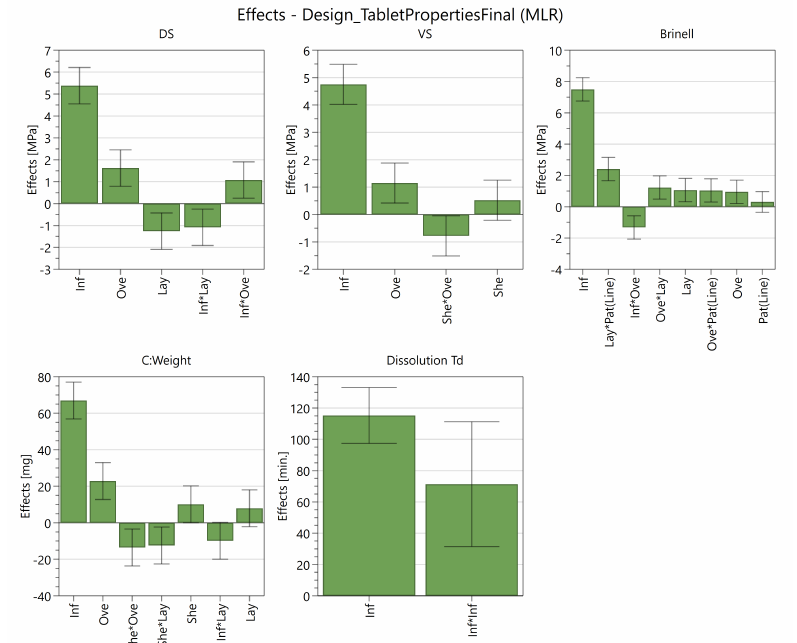
Figure 7. Optimized effect plots of the Brinell hardness, diametral (DS) and vertical strength (VS), weight and dissolution properties (T d ) of the FDM 3D-printed caplets.